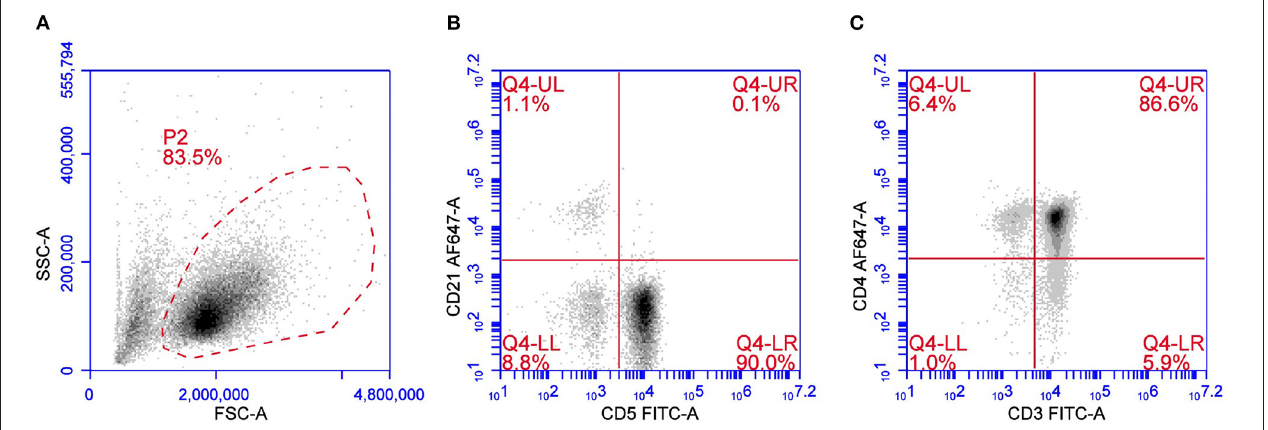
FIGURE 1 | Flow cytometric presentation of a PTCL. (A) Forward scatter (FSC) vs. side scatter (SSC) plot after doublet exclusion showing a unique population of medium-to-large sized cells. (B,C) CD5 vs. CD21 plot (B) and CD3 vs. CD4 plot (C) of P2-gated cells showing a predominant population of CD5 + CD3 + CD4 + cells.